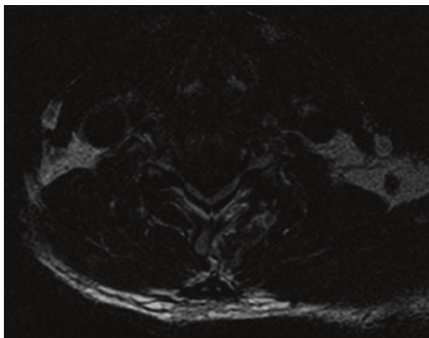
F 1: Preoperative axial T2-weighted MRI showing severe C5-6